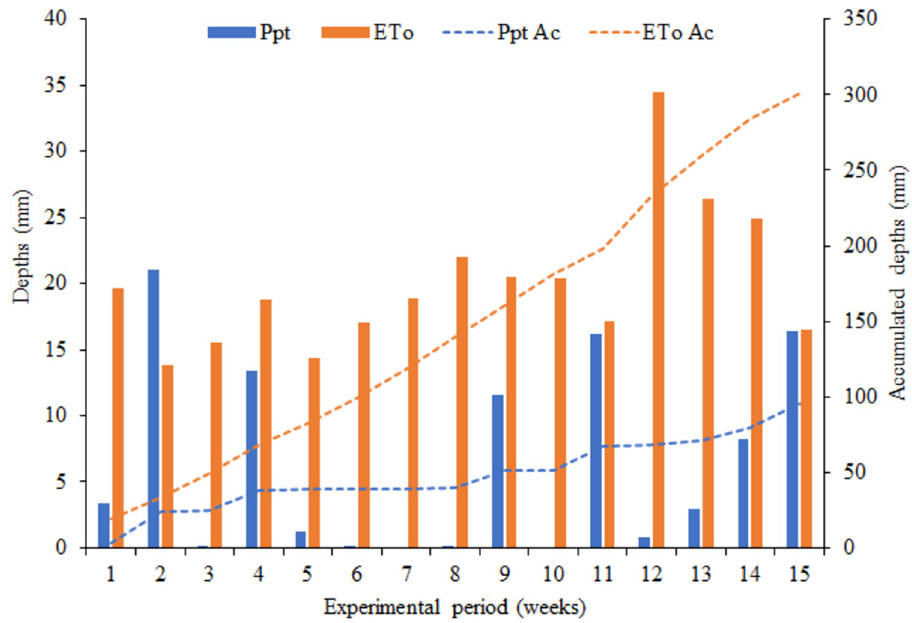
Fig 2. Precipitation (Ppt) and reference evapotranspiration (ETo) depths along the experimental period.